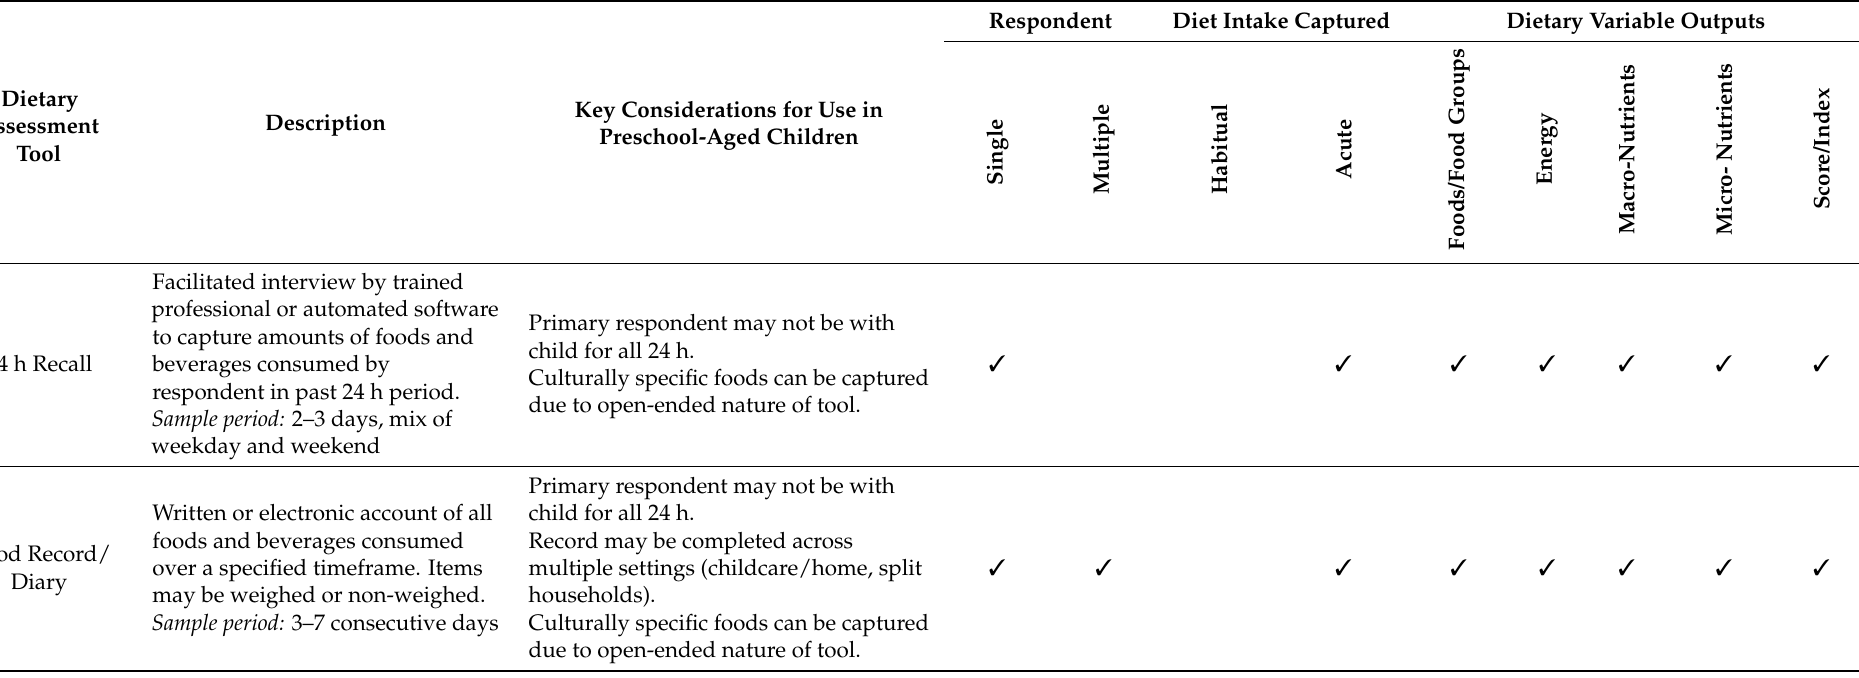
Table 1. Diet assessment tools used with preschool-aged children